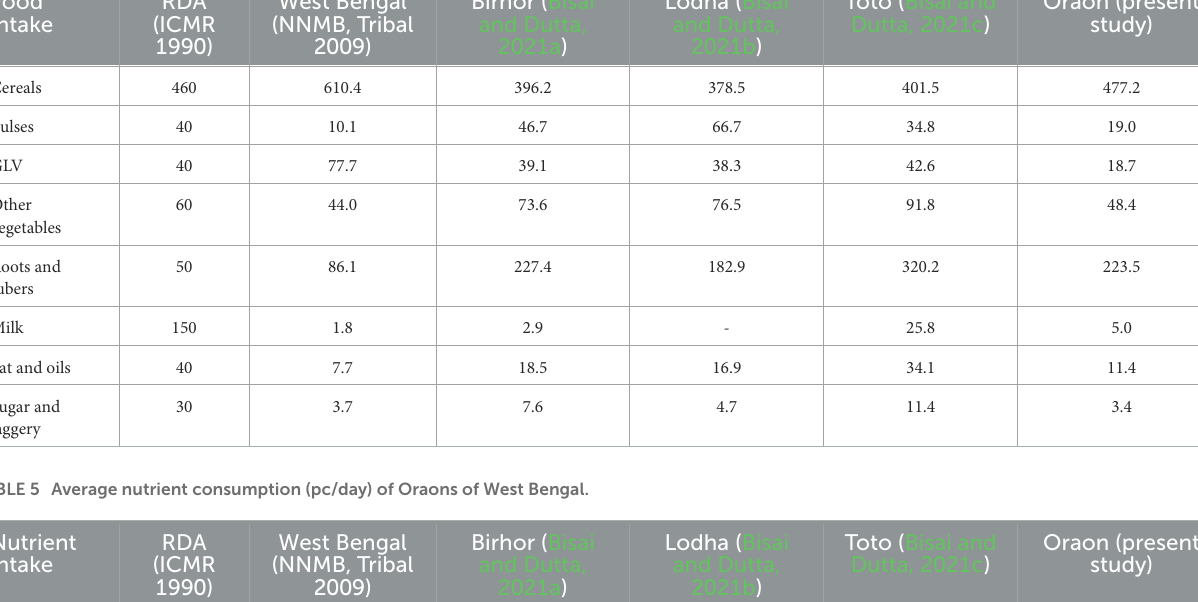
TABLE 4 Average foodstuff consumption (g/pc/day) of Oraons of West Bengal.